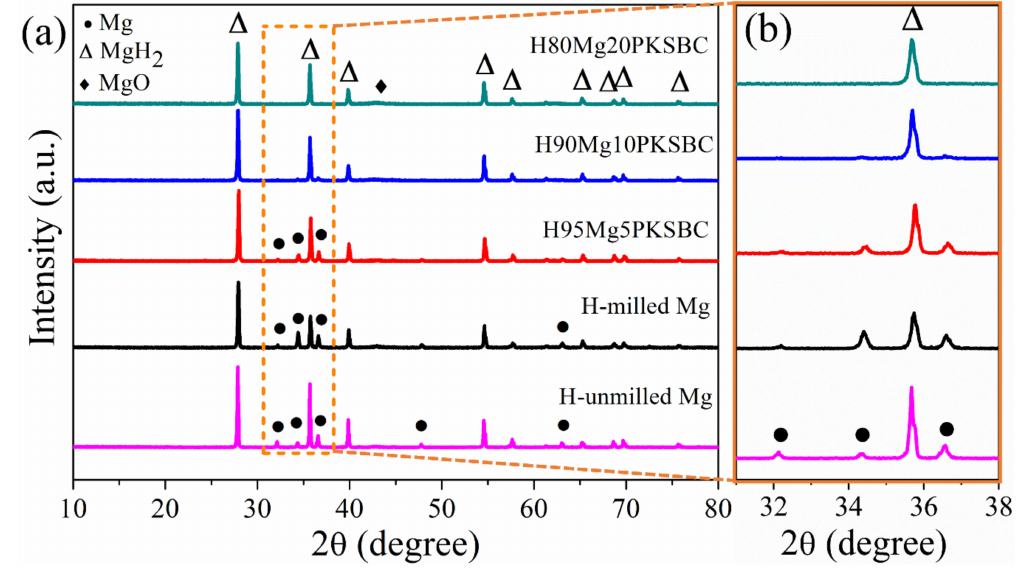
Figure 7. XRD patterns of ( a ) hydrided Mg / PKSBC at 360 ◦ C and ( b ) enlarged rectangle in